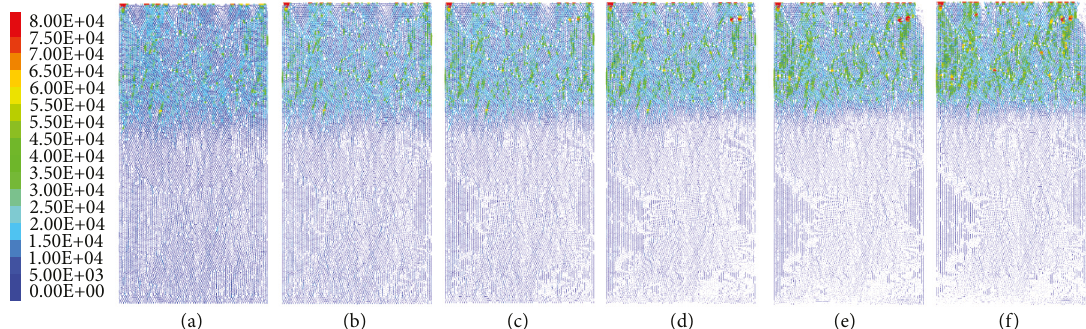
Figure 11: Contact force distribution under different amplitudes: (a) 50%, (b) 60%, (c) 70%, (d) 80%, (e) 90%, (f) 100%.